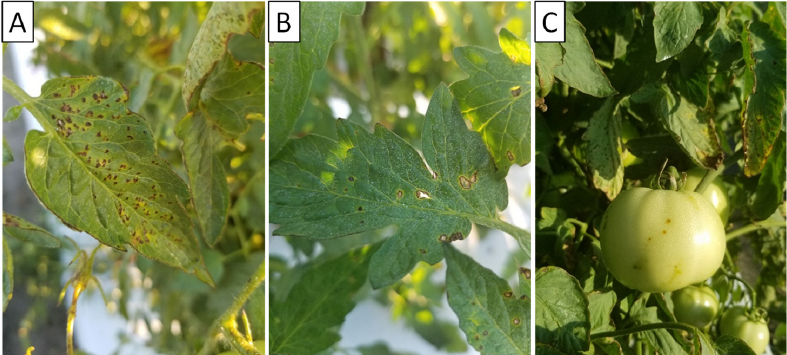
Figure 1. Leaf spots on tomato leaves caused by X. perforans ( A ), including shot-hole pattern leaf lesions ( B ), and upraised scabby lesions on fruit ( C ). Gary Vallad, UF/IFAS. The current treatment for BST is based on recommendations from 40 years ago [14], and the related literature used older tomato varieties (“Walter”), along with production methods that are not currently used by farmers [14,15]. The scienti fi c recommendation was “copper alone and in combination with maneb [growers now use mancozeb, since maneb is no longer commercially available in the US] …no other materials are recom- mended in Florida for control of bacterial spot of tomato” [14]. In addition, the pathogen strains used in their experiments were X. euvesicatoria instead of X. perforans , which is the current cause of the disease in Florida. X. euvesicatoria was copper-sensitive, while X. per- forans populations in Florida are copper-tolerant [16,17].